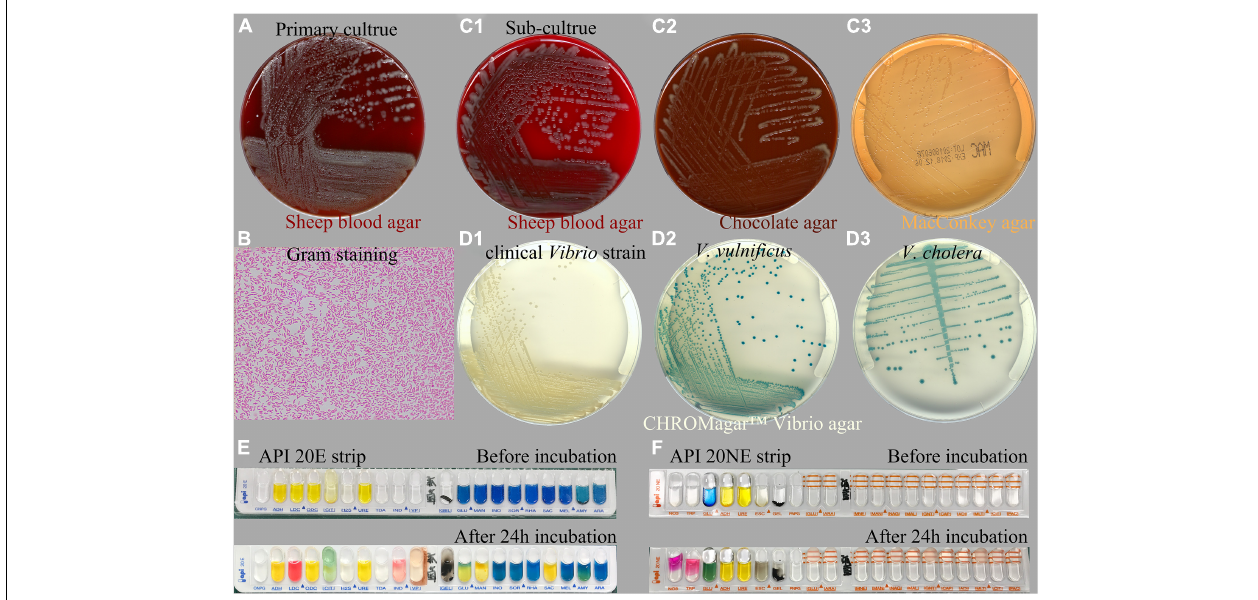
FIGURE 2 | Microbiological characteristics of the Vibrio alginolyticus strain responsible for chronic ear infection. Cultures of the specimen obtained from the ear infection drainage revealed the large growth of a Gram-negative bacterium (A) . Gram staining of cultured Vibrio colonies showed a Gram-negative, curved, and rod-shaped morphology (B) . Sub-culture of Vibrio on sheep blood (C1) , chocolate (C2) , and MacConkey agar media (C3) . For confirmation, the isolate appeared to be creamy, as expected for V. alginolyticus when sub-cultured on a CHROMagar TM Vibrio-selective agar (D1) , whereas the control isolates of Vibrio vulnificus (D2) , and Vibrio cholera (D3) appeared to be green-blue to turquoise-blue. Biochemical investigation of the tested strain using API 20E (E) and 20NE (F) strips identified the isolate as V. alginolyticus